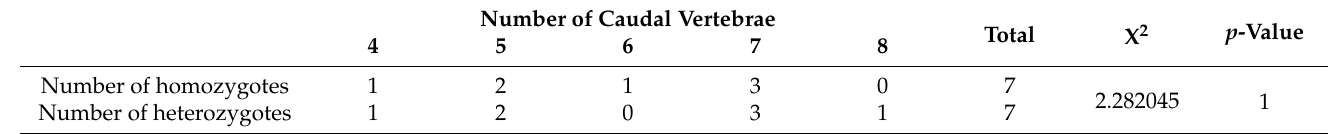
Table 4. Statistics on the number and genotype of caudal vertebrae in short-tailed sheep.